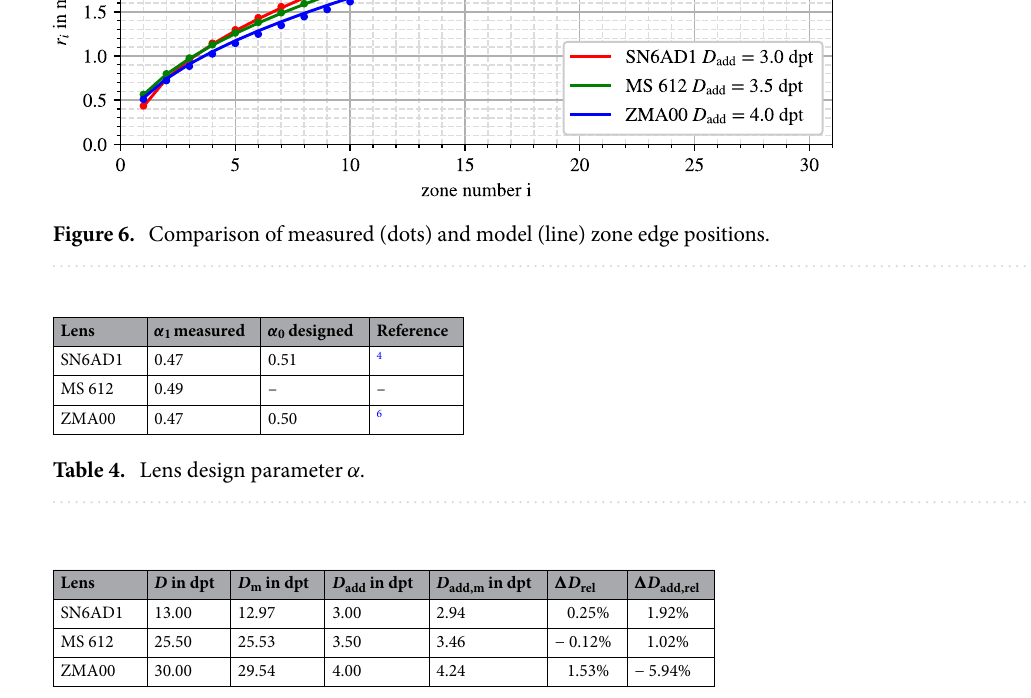
Table 5. Power deviation